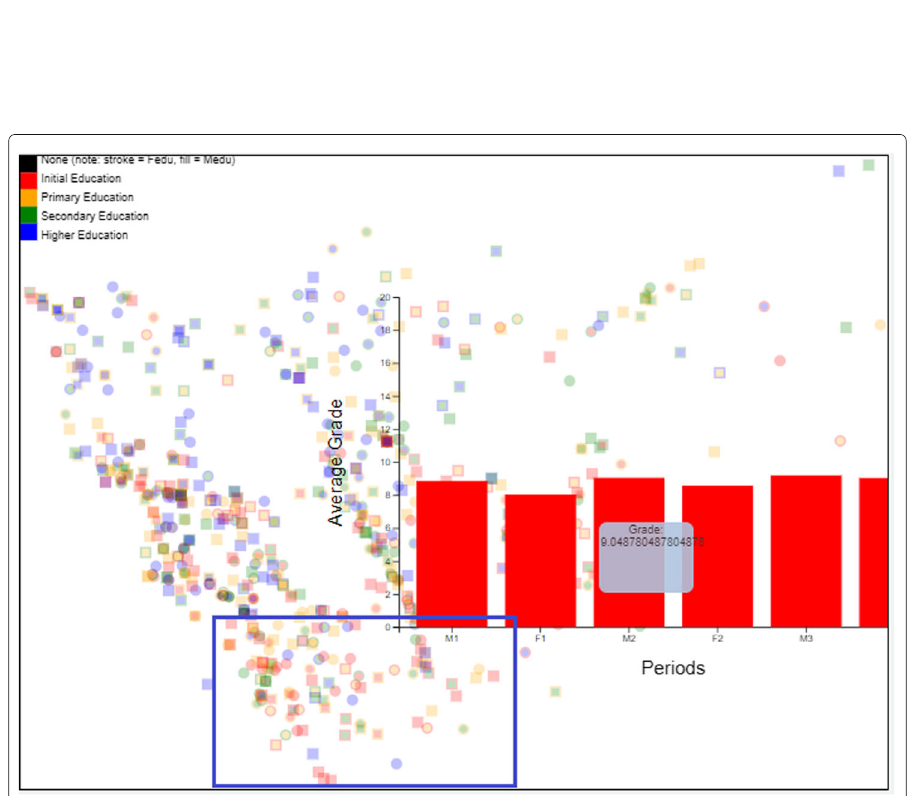
Fig. 25 Isomap for "Portuguese" class, all periods, considering both genders, and a group